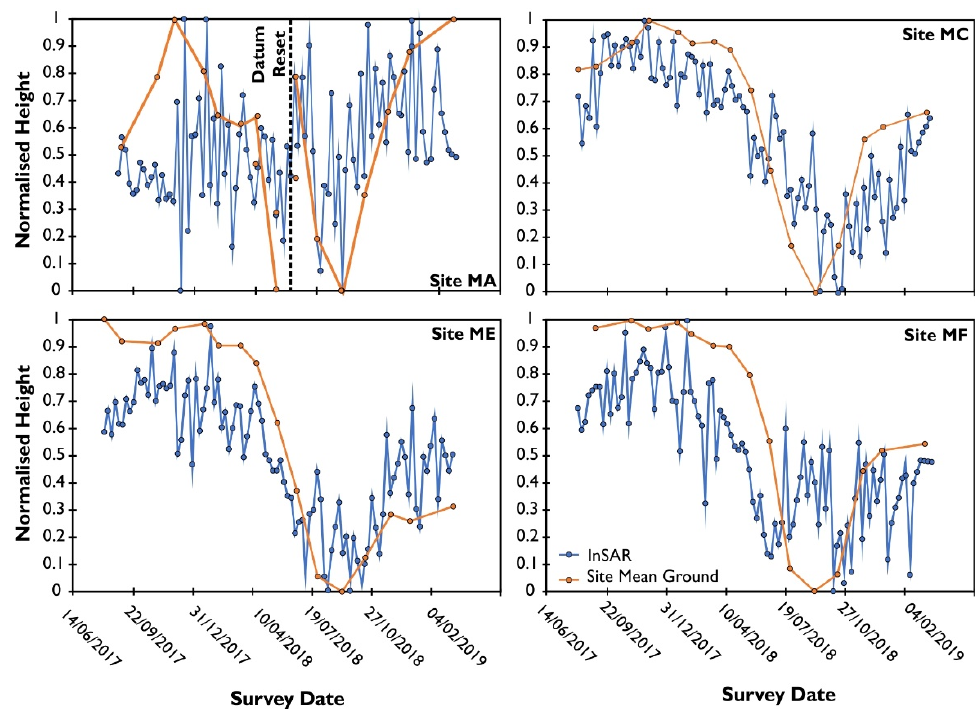
Figure 6. Min/Max Normalized comparison of APSIS InSAR and mean subsite ground precise leveling data at subsites M-A, M-C, M-E and M-F which underestimated motion during the 2018 drought event showing good agreement post normalization. Site M-A required a reset of datum to allow comparison as indicated by the dashed vertical line.